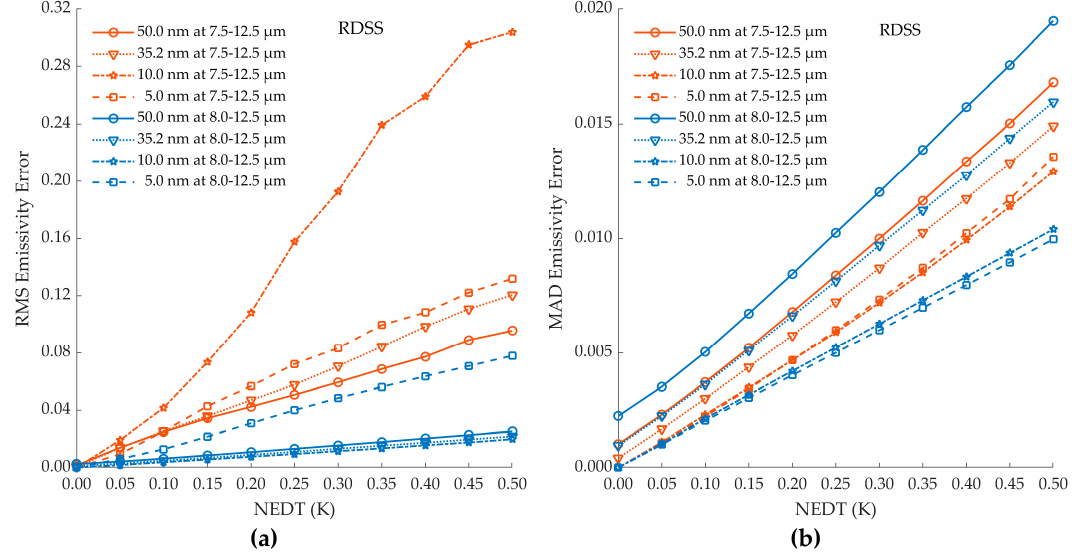
Figure 6. Plots of RDSS retrieved LSE errors varying with NEDT, spectral range and spectral resolution. ( a ) The retrieved LSE RMSE and ( b ) the retrieved LSE MAD.